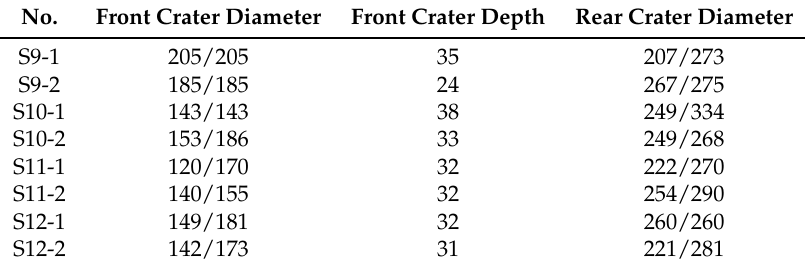
Table 6. Blast damage for PVA-Steel HFRC panels (in mm).